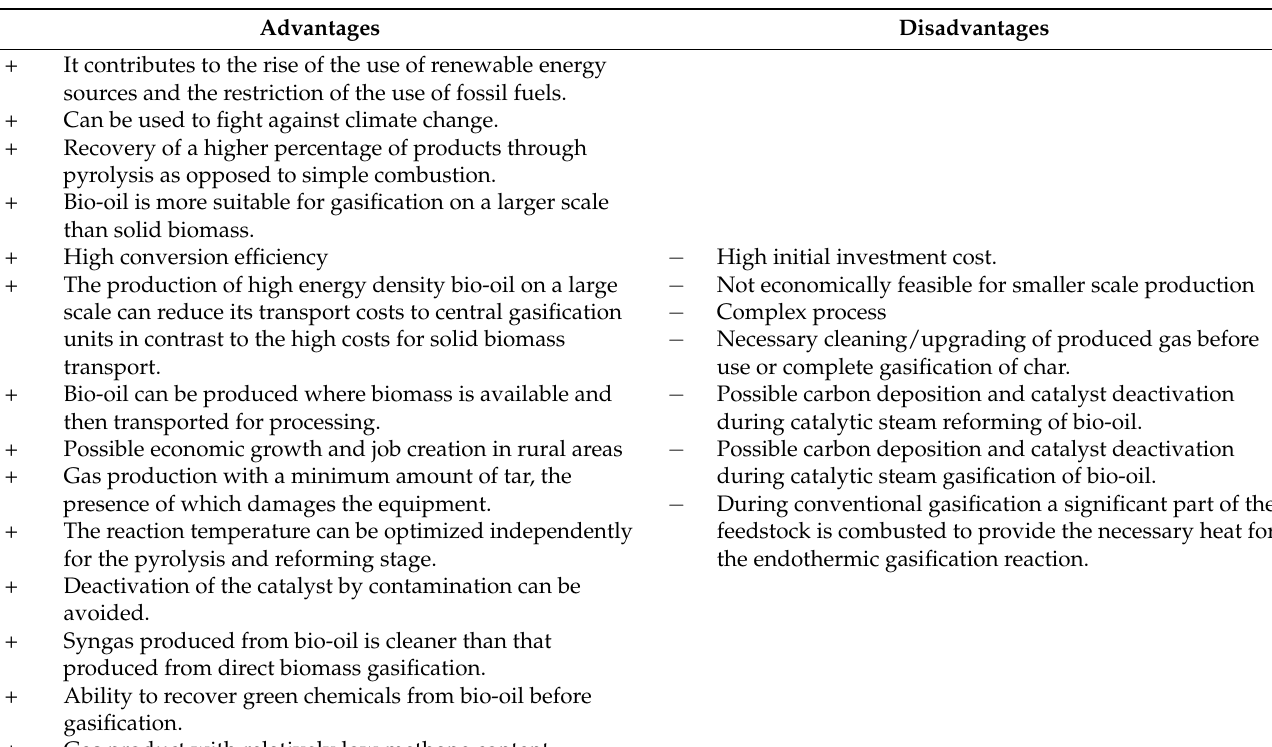
Table 12. Advantages and disadvantages of pyrolysis and gasification